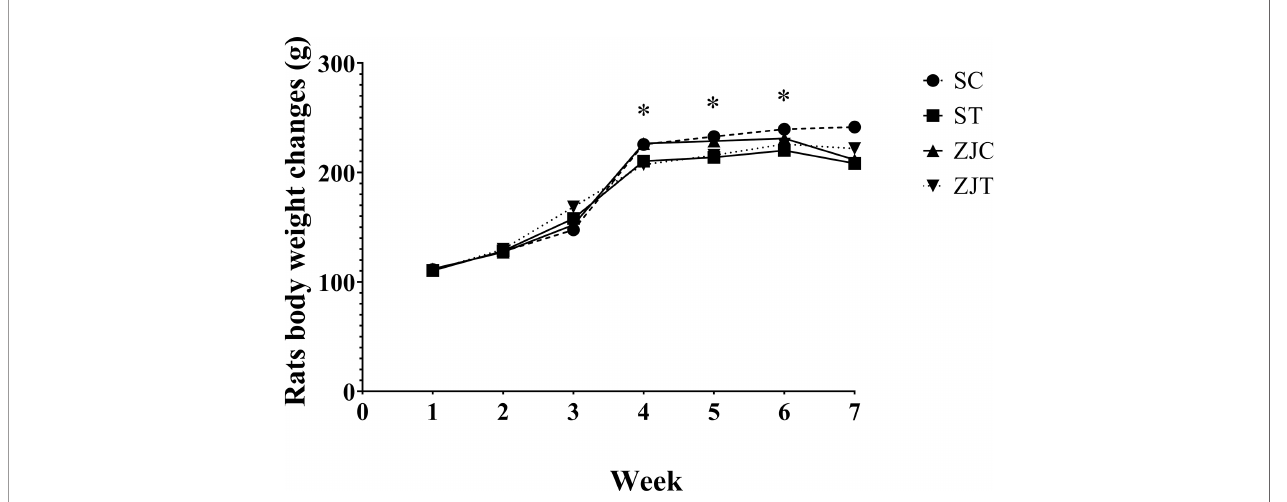
FIGURE 1 | Rats body weight (g) in Saline-Control (SC), Saline-High Intensity Training (ST), Ziziphus jujuba -Control (ZJC), and Ziziphus jujuba -High Intensity Training (ZJT) groups. Data were expressed mean, P value set at < 0.05, and 7 rats per each group. * Training main effect (P=0.008 for 4 th week, P=0.01 for 5 th week and P=0.05 for 6 th